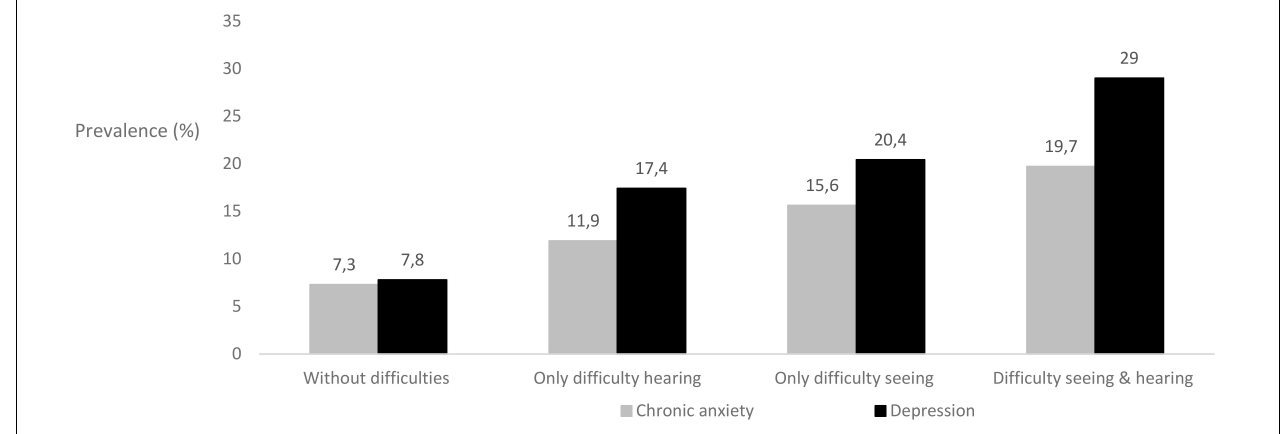
FIGURE 1 | Prevalence of depression and chronic anxiety in Spanish adults with seeing and hearing